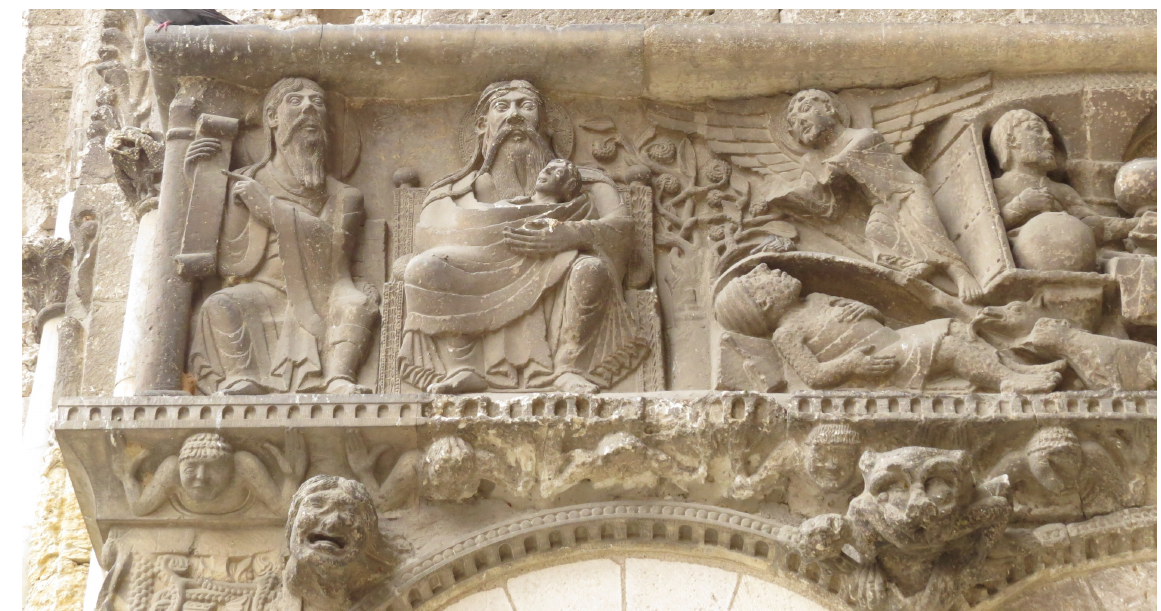
Figure 28. Abraham and Lazarus, detail of west wall, south portal, Saint-Pierre-de-Moissac Abbey , 1115–1130, Moissac, Tarn-et-Garonne, Occitanie, France. ©Author.